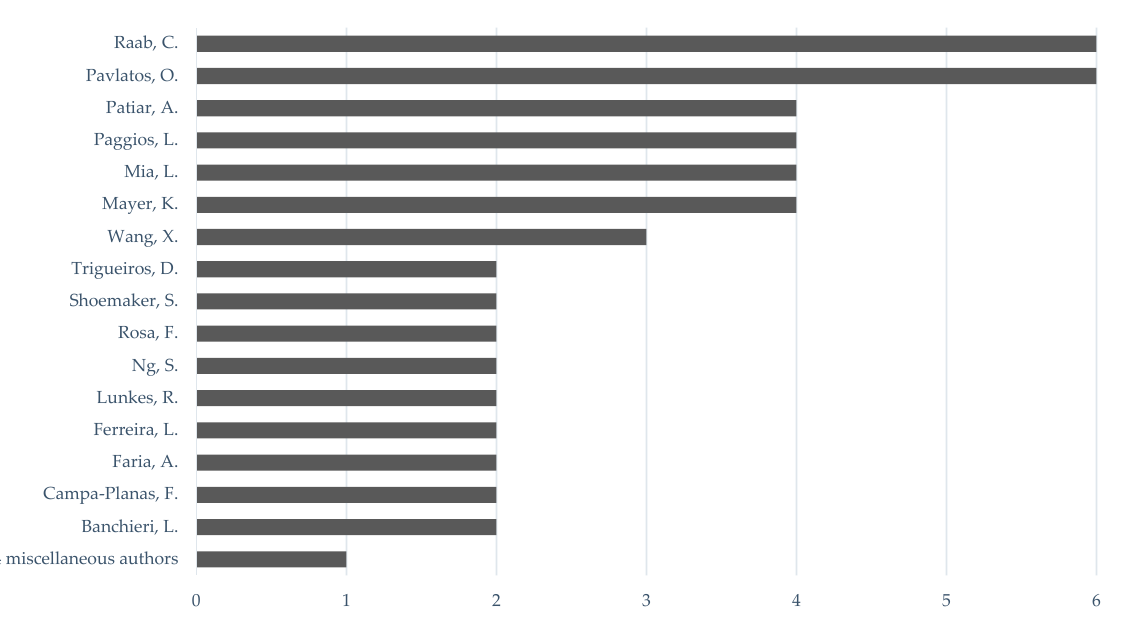
Figure 5. Authors in the sample.